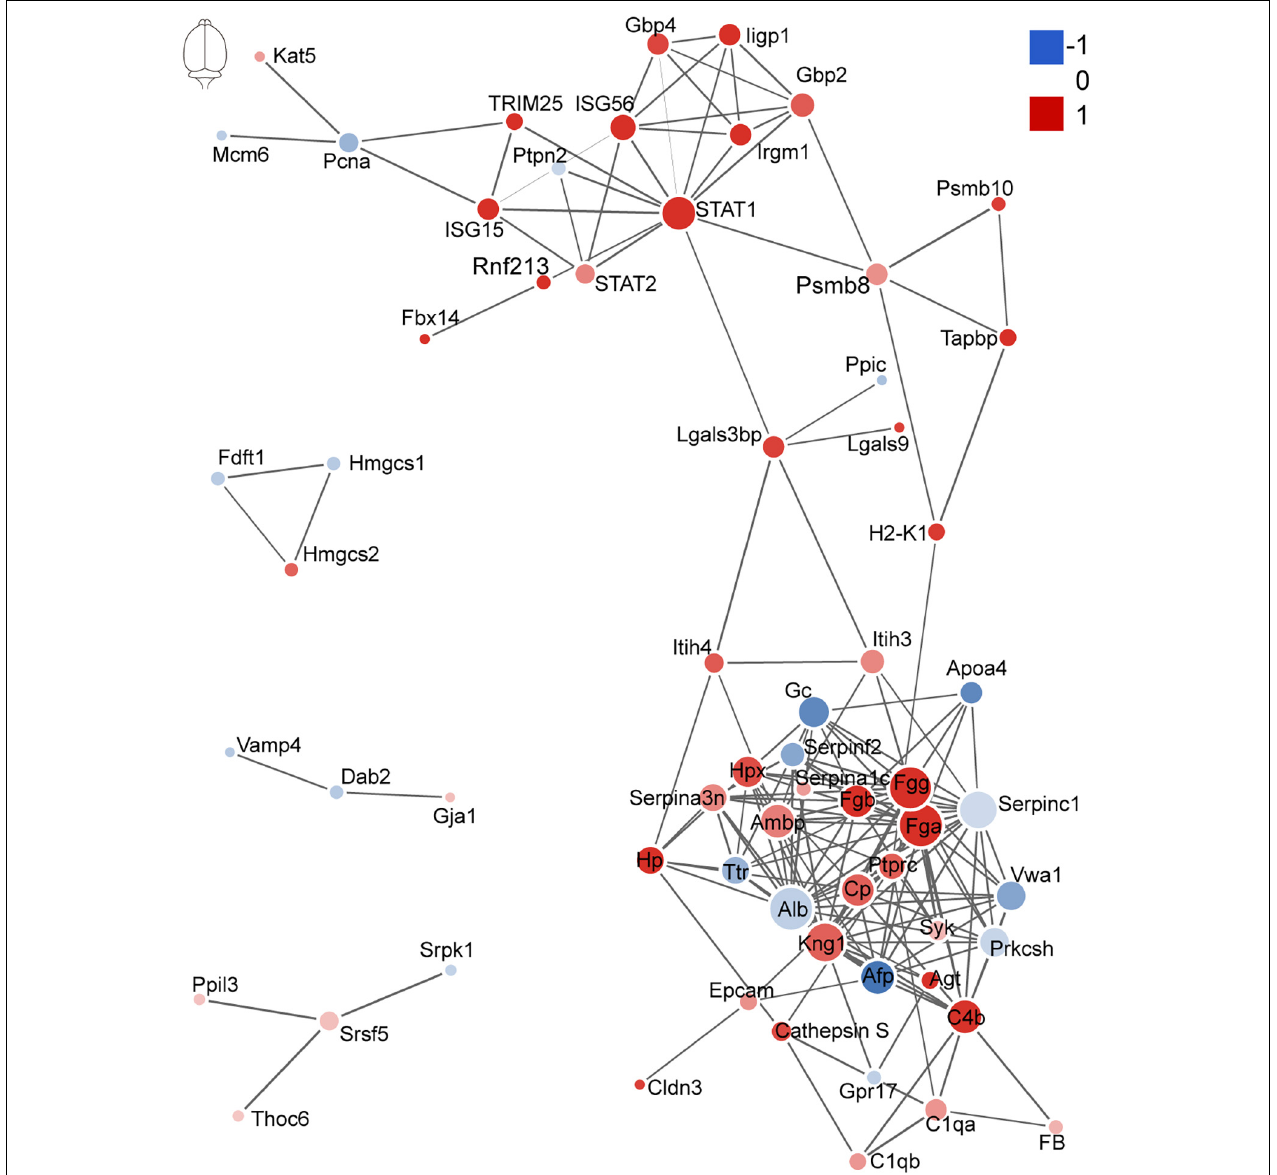
FIGURE 6 | Protein–protein interaction analysis of dysregulated proteins in the brain. The size of the nodes corresponds to the number of interacting proteins, whereas the different colors represent the regulation type and magnitude of protein changes. Red color represents upregulation, and blue color represents downregulation. The full list of key driver proteins can be found in Supplementary Table 3